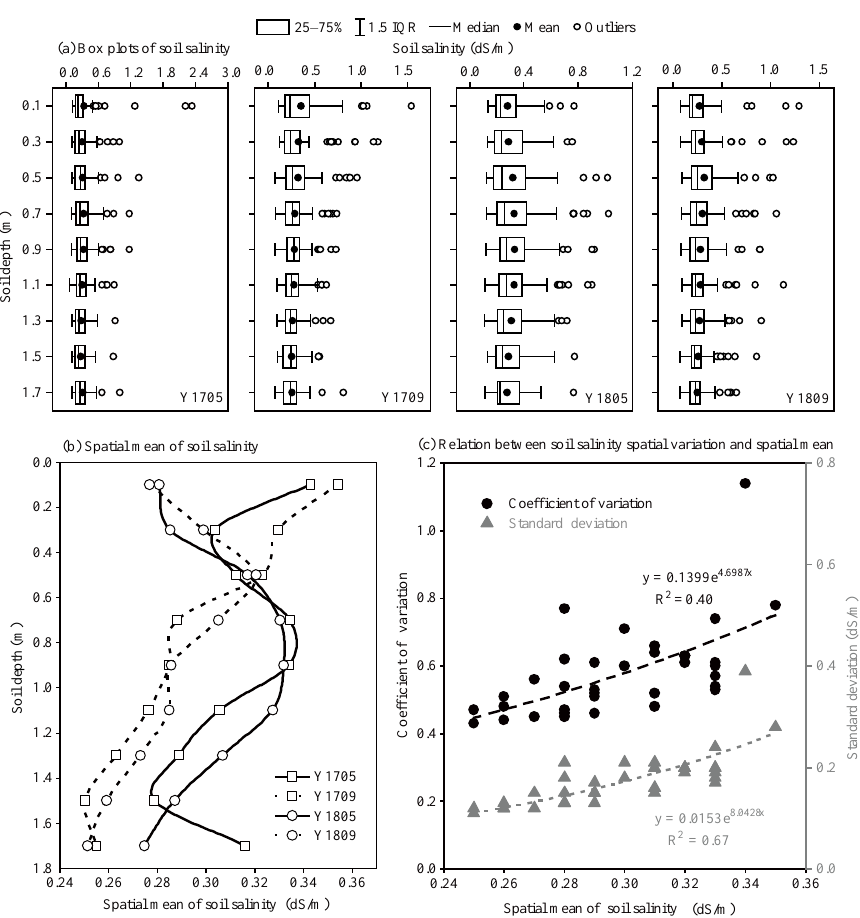
Figure 3. Soil salinity and its spatial variation at different depths for the four sampling times. ( a ) Box plots of soil salinity. The boxes indicate the 25th and 75th percentile (25–75%), and the